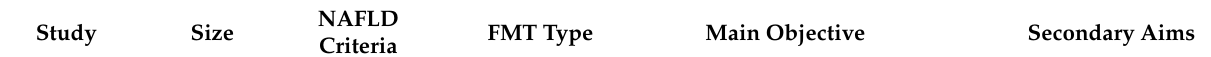
Table 3. Summary of published studies on faecal microbiota transplantation performed in patients with non-alcoholic fatty liver disease